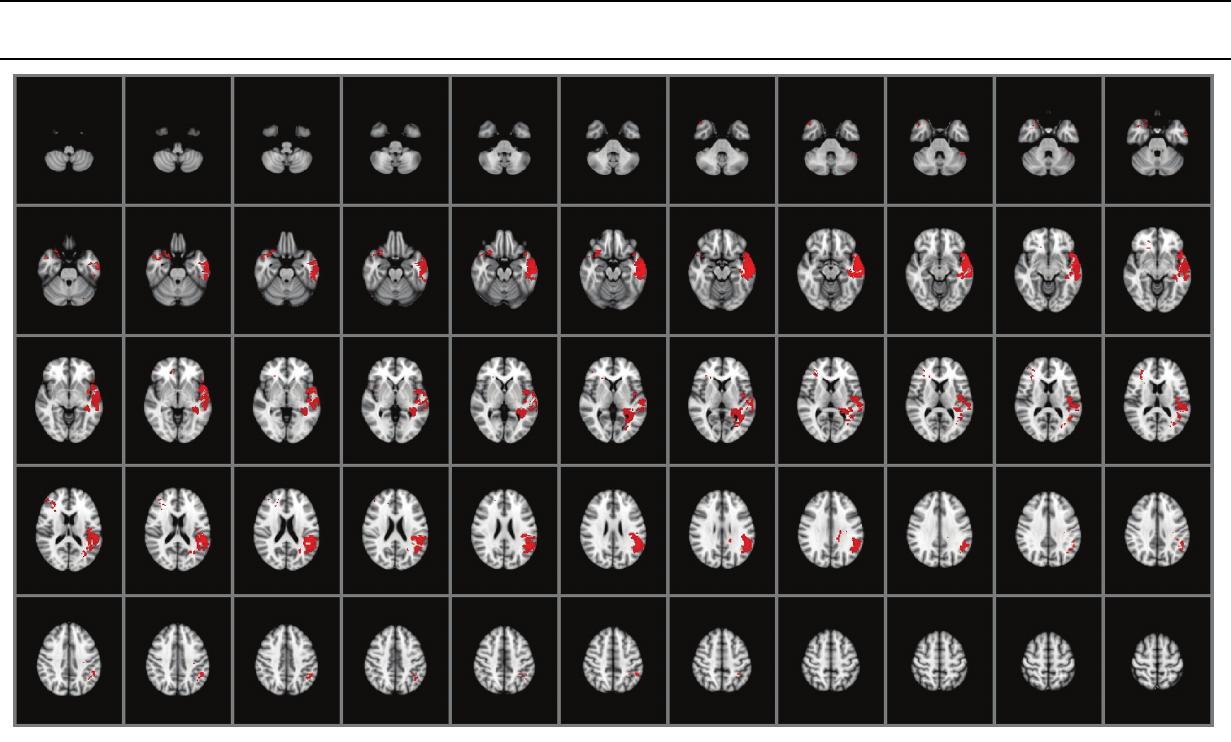
Frontiers in Human Neuroscience | www.frontiersin.org